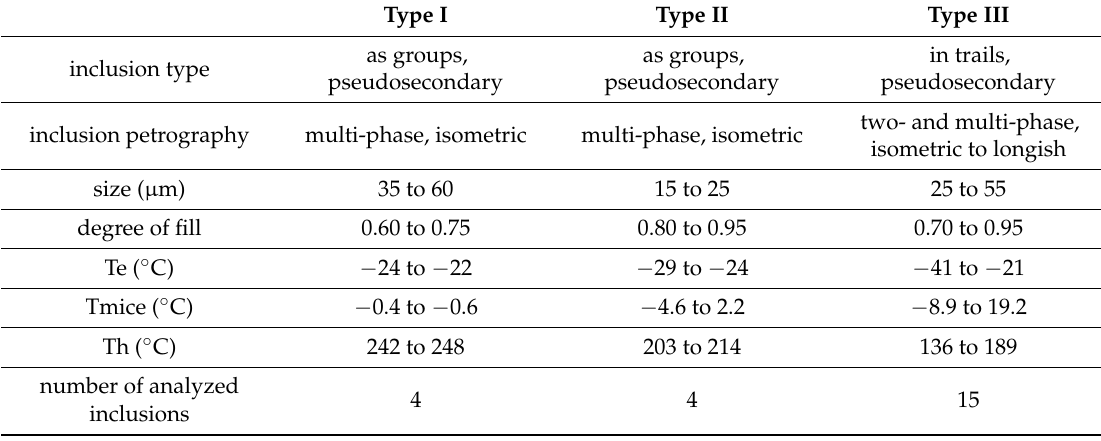
Table 5. Summary of petrographic and microthermometric data of primary and pseudosecondary fluid inclusions in quartz crystals from the Berglia-Glassberget breccia. Te—temperature of first melting, Tmice—temperature of final ice melting, Th—temperature of